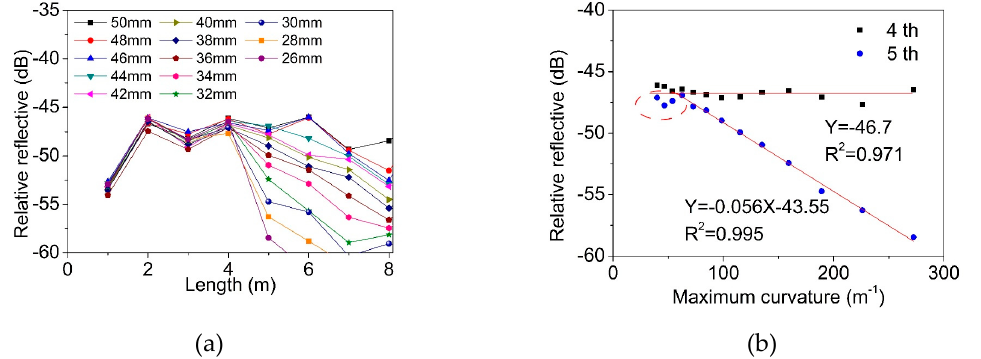
Figure 13. Relative change of reflection peak intensity for ( a ) all FBG and ( b ) single FBG when the axial strain distance from 0 mm to 24 mm. strain distance from 0 mm to 24